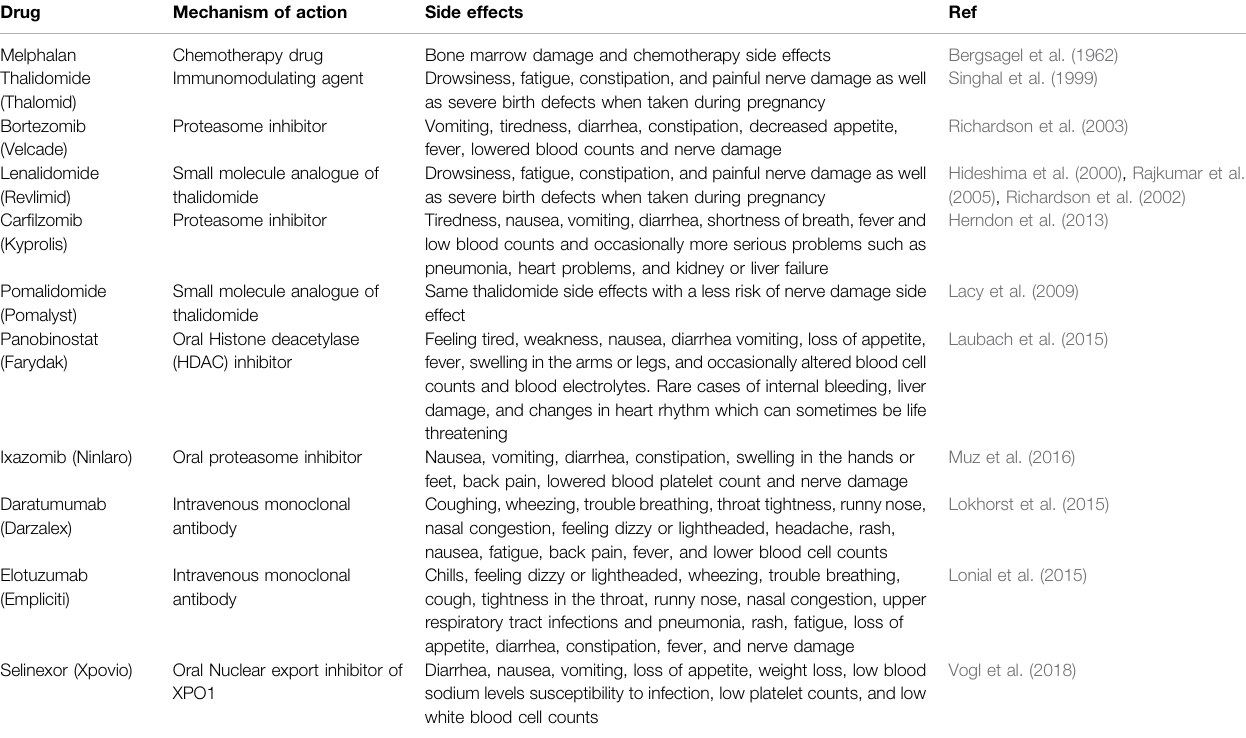
TABLE 1 | Mechanism of action and Side effects of Common Therapy in